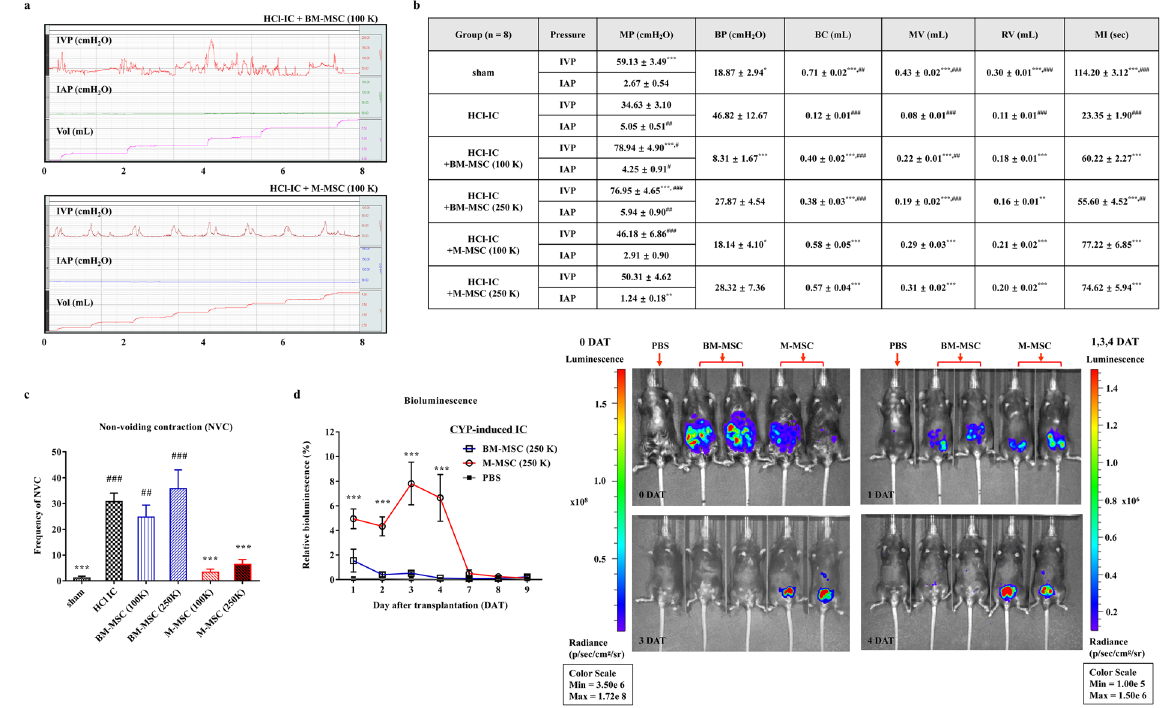
Figure 6. Superior therapeutic efficacy of M-MSCs compared to BM-MSCs. ( a ) Representative awake cystometry results at 1 week after injection of M-MSCs or BM-MSCs at the indicated dosage (K = a thousand) into the bladder of HCl-IC rats. ( b ) The micturition pressure (MP), basal bladder pressure (BP), bladder capacity (BC), micturition volume (MV), residual volume (RV), and micturition interval (MI) were quantified from the voiding pattern analysis. ( c ) Quantification of non-voiding contraction (NVC) in HCl-IC animals transplanted with the indicated number of M-MSCs or BM-MSCs (n = 8). All data are presented as the mean ± SEM from 8 independent animals per group ( * p < 0.05, ** p < 0.01, *** p < 0.001 compared to the HCl-IC group; # p < 0.05, ## p < 0.001, ### p < 0.001 compared to M-MSC (250 K) group by one-way analysis of variance with Bonferroni post-test). ( d ) The time course of viability of transplanted M-MSCs or BM-MSCs (2.0 × 10 5 ) in cyclophosphamide (CYP)-induced IC/BPS mice. Relative bioluminescent signals for the indicated day after transplantation (DAT) relative to 0 DAT are presented as the mean ± SEM (n = 5; *** p < 0.001 compared to the BM-MSC group). The representative images were obtained at 15 minutes after intraperitoneal injection of 150 μ g/ml coelenterazine (200 μ L), a substrates for Renilla luciferase. The scale bars for optical image density range at 0 and other day points were presented at left and right sides of image,